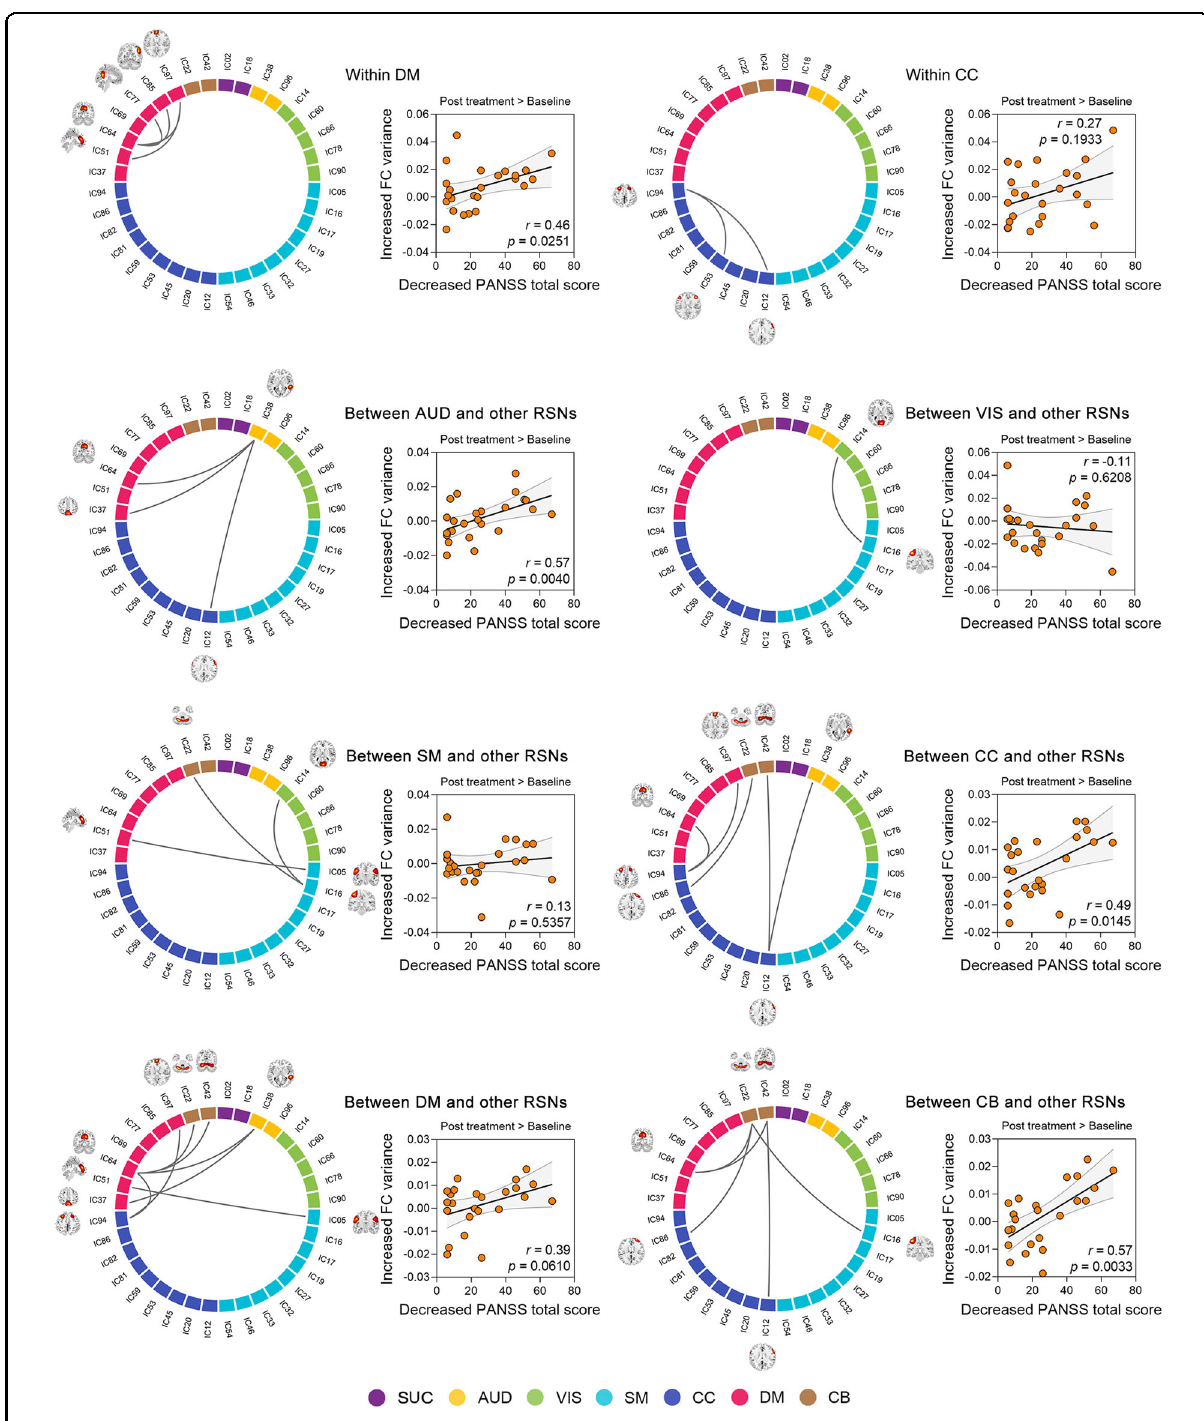
Fig. 3 Associations between altered FC variability of intra- and inter-RSNs and relief of psychosis symptoms. Signi fi cance, P < 0.05, FDR-